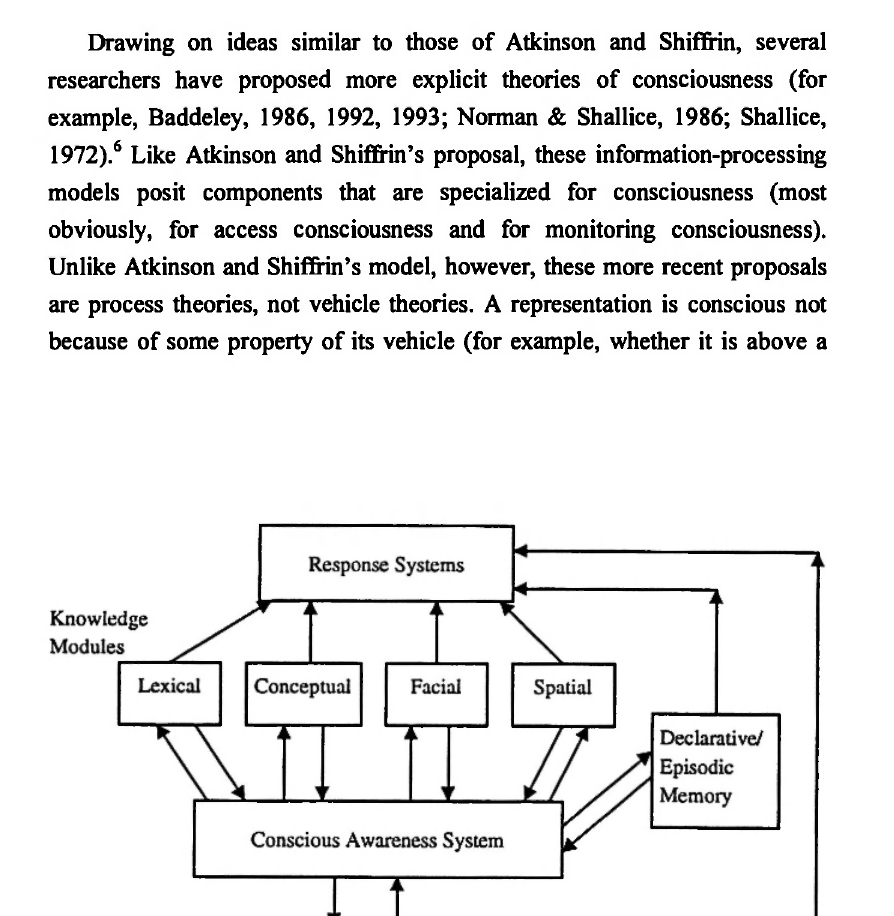
Fig. 3: Schacter's (0989) DICE consciousness box